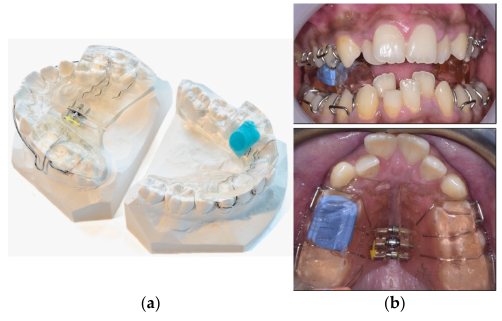
( b ) Figure 2. Micro-electronic thermal biosensors embedded in different locations of myofunctional ap- pliances to monitor wear-time: ( a ) lingual flange of the lower block, Reprinted with permission from [45]; ( b ) in the upper block, Reprinted from [46], with permission from Elsevier. The majority of the sensors used intraorally are temperature-sensitive microsensors that detect and measure intraoral temperature when the appliances are in the mouth and translate the information into wear time [45,49,50,53,54,58–60]. The safety and cytotoxicity of thermal microsensors have been successfully evaluated [61], reinforcing that it is pos- sible to opt for them to objectively monitor compliance. In addition to measuring temper- ature to a 0.1 °C resolution, a micro-electronic sensor that also detects the spatial orienta- tion/movement in the x-, y-, and z-axes to a 2° angulation resolution and head position (DentiTrac ® , Braebon Medical Corporation, Ottawa, ON, Canada) has also been described.